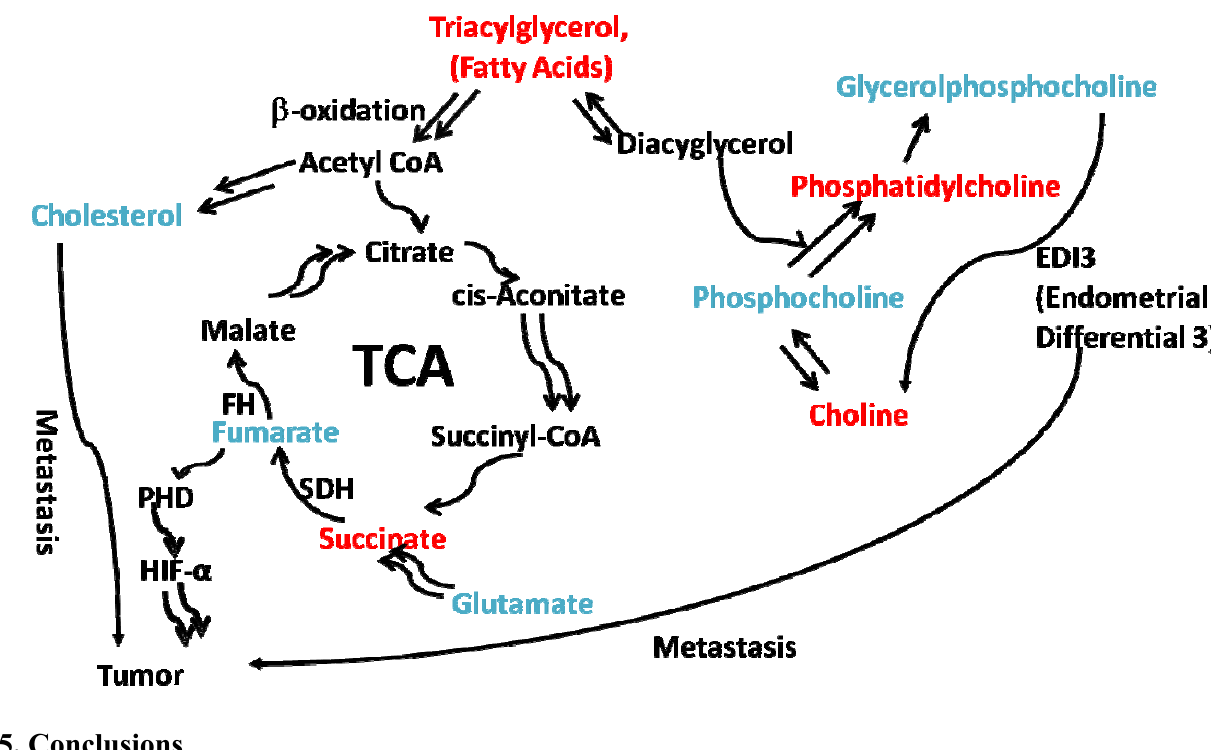
Figure 8. Proposed pathway in melanoma development, i.e. , the reactions between different metabolites. Here, all metabolites increased in the tumor group (as compared to the controls) are in blue, and all metabolites decreased in the tumor group (as compared to the controls) are in red, unchanged (including not detected) metabolites in the pathway, are in